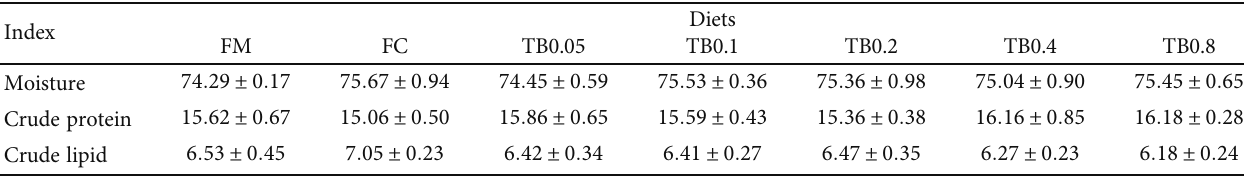
Table 5: E ff ects of tributyrin supplementation on whole body proximate composition (wet weight, %) in juvenile large yellow croaker fed